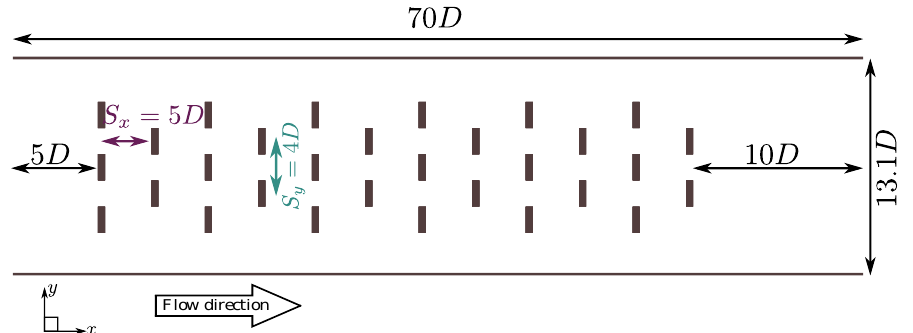
Figure 1. Schematic distribution of disks for the validation of numerical simulations, following the laboratory experiments of Chamorro and Porté-Agel [29] and Markfort et al.